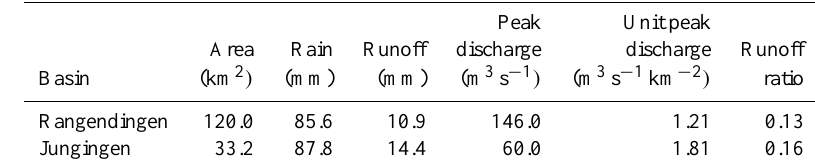
Table 3. Rainfall and runoff properties for the 2 June 2008 flood analysed at Rangendingen and at Jungingen (analysis based on the hydrological model application).